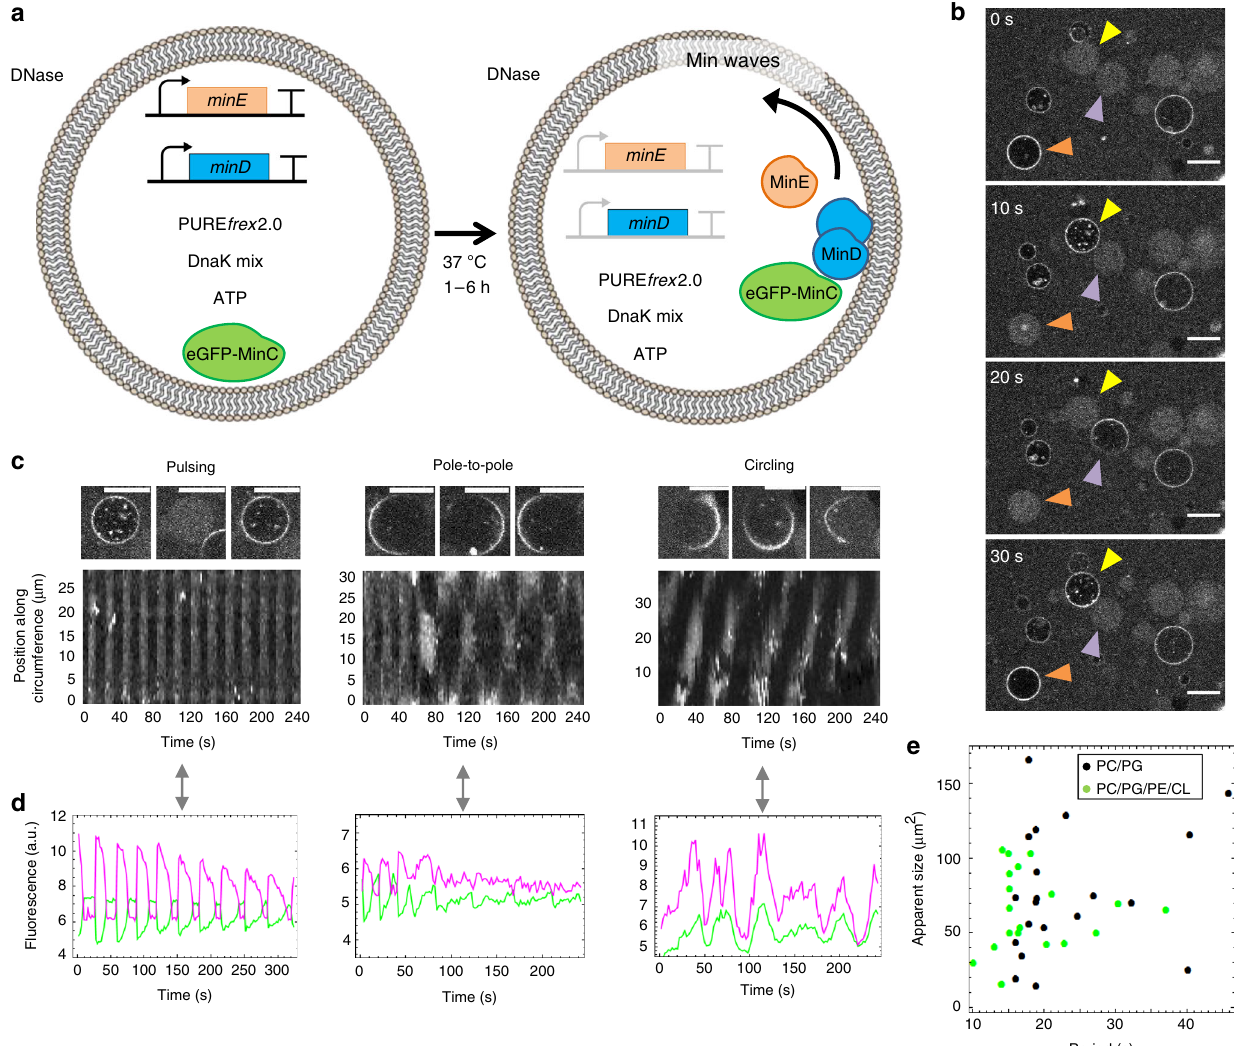
Fig. 3 In-liposome production and self-organization of MinDE proteins. a Schematic illustration of liposome reconstitution assays. The minD and minE genes are co-expressed within phospholipid vesicles in the presence of DnaK chaperones, extra ATP, and 1 µ M of puri fi ed eGFP-MinC to report for MinDE dynamics. b Time-series images showing liposomes (PC/PG composition) exhibiting periodic redistribution of eGFP-MinC between the membrane and the lumen (Supplementary Movie 4). Colored arrowheads point to Min-active liposomes. Other liposomes show stable fl uorescence signal at the membrane or in the lumen throughout the image sequence. Scale bars are 10 µ m. c Zoomed-in images taken at three different time points (from left to right) of liposomes (PC/PG composition) exhibiting the pulsing, pole-to-pole, or circling modes of oscillations (Supplementary Movie 5). The corresponding kymographs are displayed below. Scale bars are 10 µ m. d Time traces of the fl uorescence intensity of eGFP-MinC at the membrane (magenta) and in the lumen (green) for the three liposomes shown in c . a.u., arbitrary unit. e The effects of lipid composition and vesicle size have been analyzed for liposomes with a Min-pulsing behavior. Both PC/PG (black dots) and PC/PG/PE/CL (green dots) liposomes show a cross-section area (averaged over the different time point images) that is not obviously correlated with the period of oscillations. Twenty liposomes of each composition have been